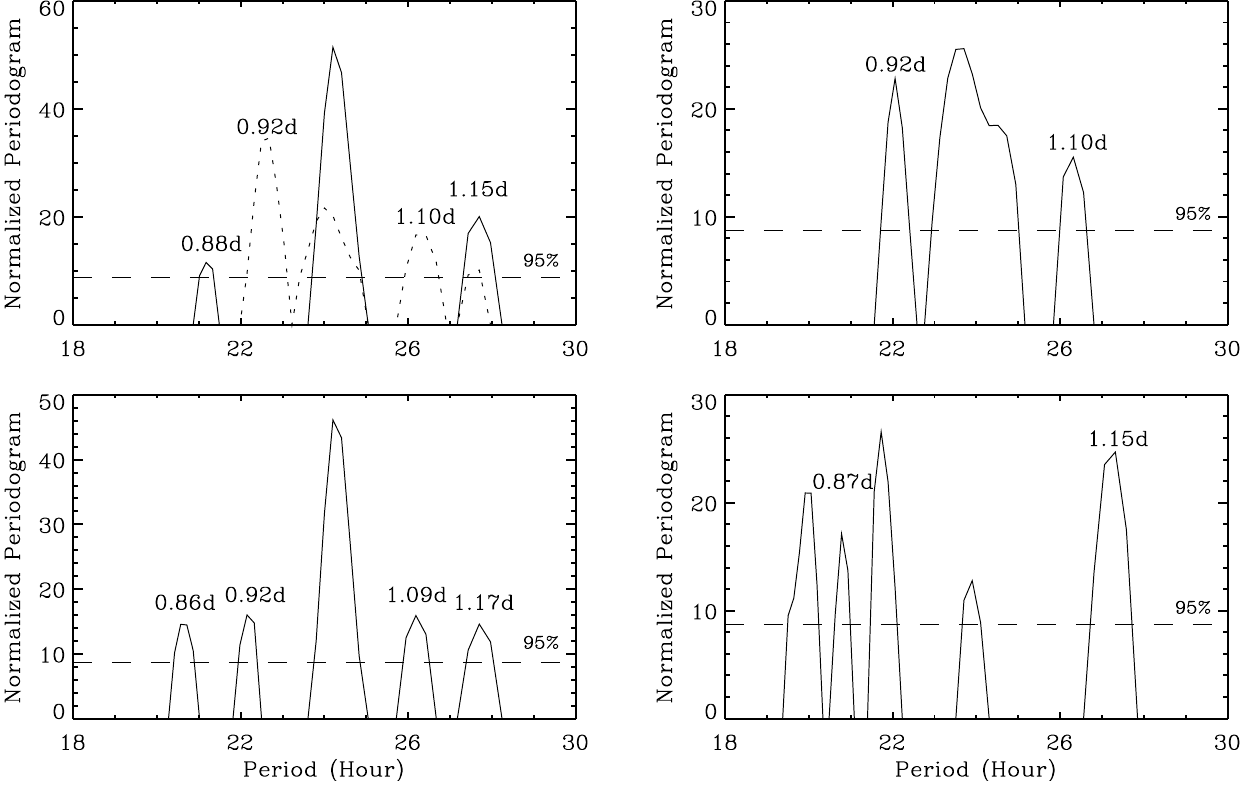
Fig. 15. Normalized Lomb-Scargle periodograms of high-pass fil- tered zonal wind disturbance (upper) at 14.1km (solid) and 20.2km (dotted), and meridional wind disturbance (lower) at 14.1km in Au- gust 2006. The dashed horizontal lines denote the confidence level of 95%.